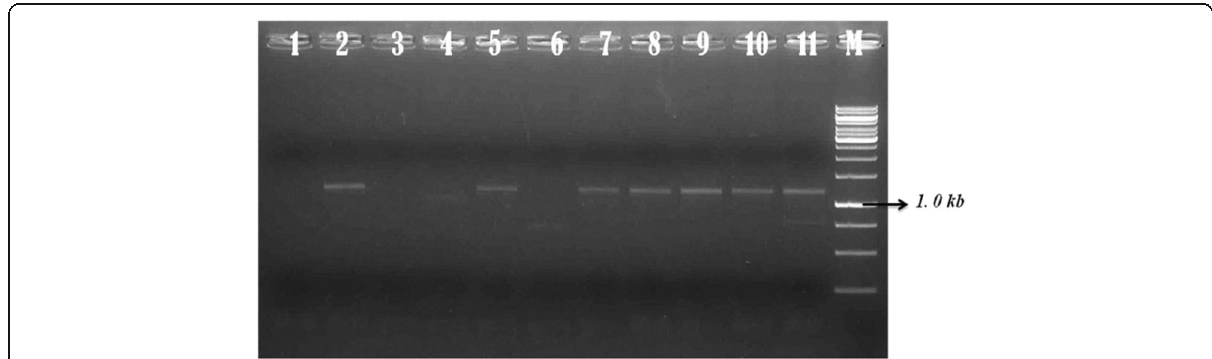
Fig. 4 The 1.5% ethidium bromide-stained agarose gel showing PCR amplification from the selected native B. thuringiensis stains using SetI primer combinations. Legends : M — Molecular Weight Marker (1.0 kb, Thermo Scientific, USA), Lane1 — BNG_Bta1, Lane2 —